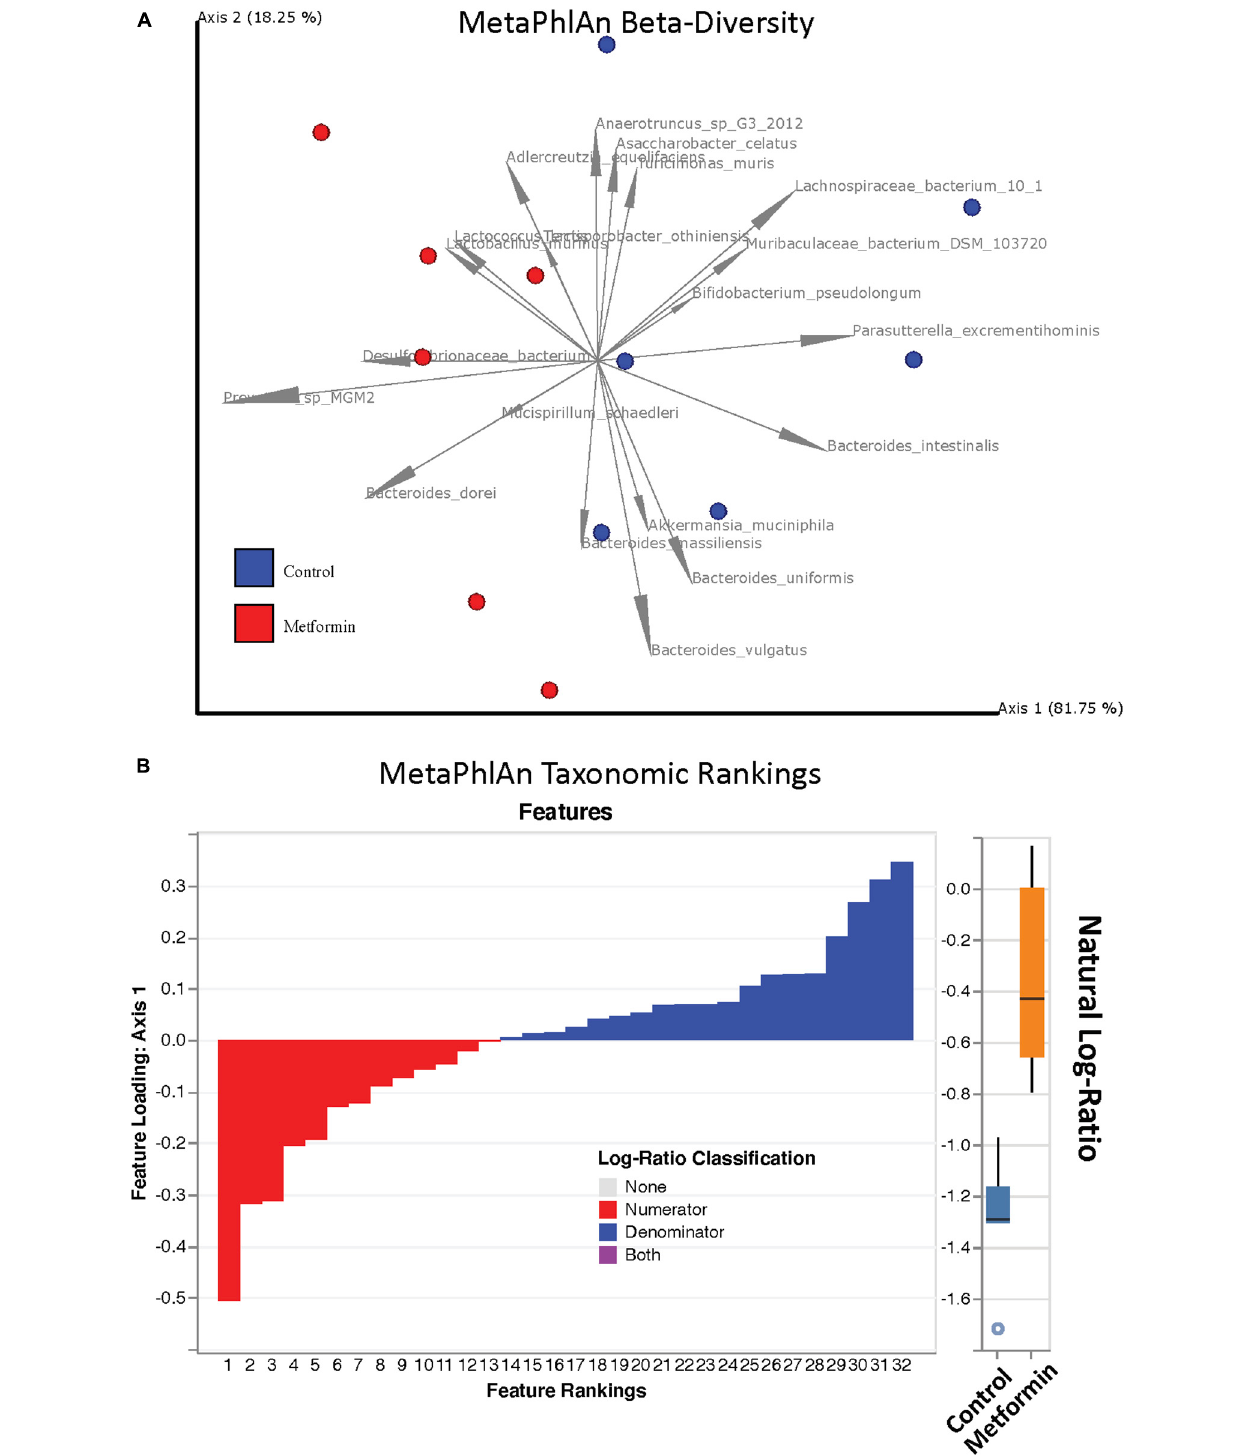
FIGURE 1 | (A) Robust Aitchison PCA plot of metagenome samples processed through MetaPhlAn 3 and DEICODE and visualized with qurro. Bacterial species not present in at least 50% of samples were removed from the analysis. Separation of Control and Metformin treated groups was significant ( p -value 0.002). (B) Corresponding log-ratio rankings for individual bacterial taxa oriented to Axis 1 (right). Numerator (red) / Denominator (blue) ratios of these taxa were computed to generate a box-whisker plot (left), p -value 0.0025. These results were corroborated with songbird analyses.